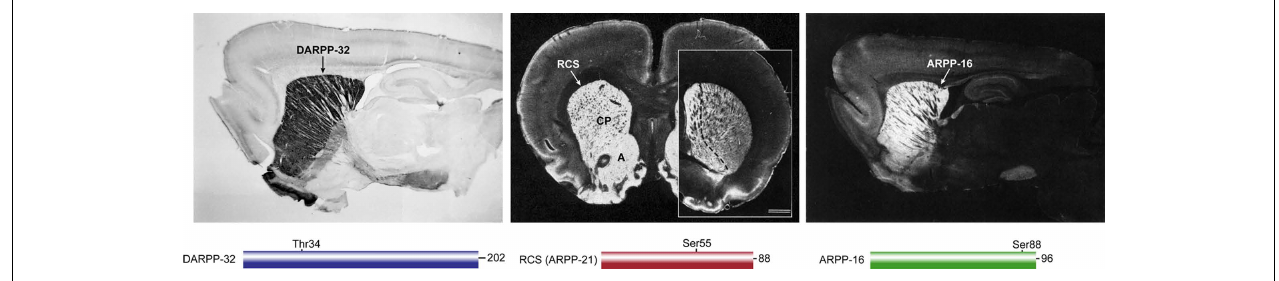
nucleus accumbens (left of dashed line) in more rostral section), ARPP-16 (right, sagittal section, immunoreactivity white). Simple domain diagrams of each protein with their amino acid number and site of PKA phosphorylation are shown below the respective immunolocalization panels.